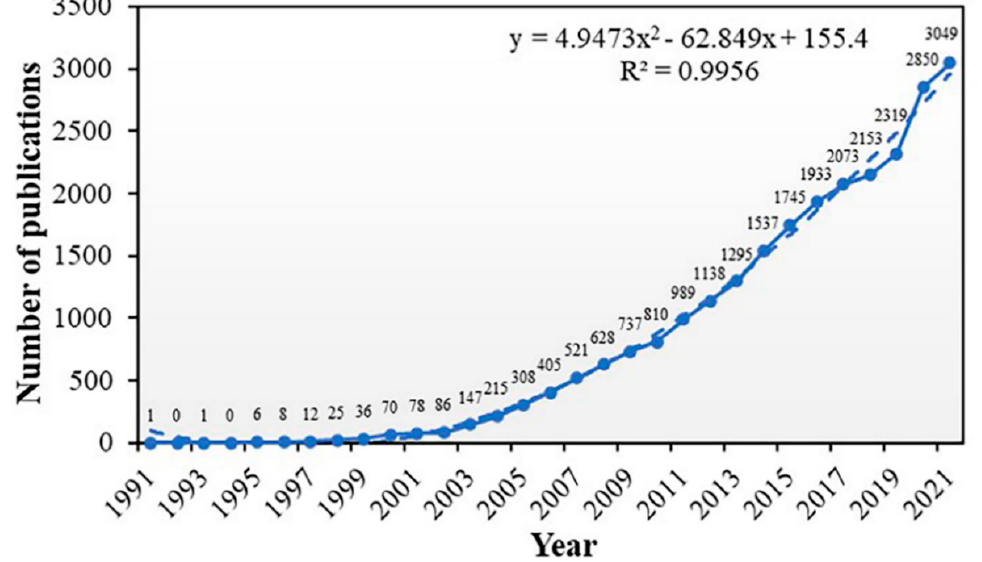
Figure 1. Number of publications worldwide from 1991 to 2021. Fitting formula (dotted line): y = 4.9473x 2 − 62.849x + 155.4 (R 2 = 0.9956).